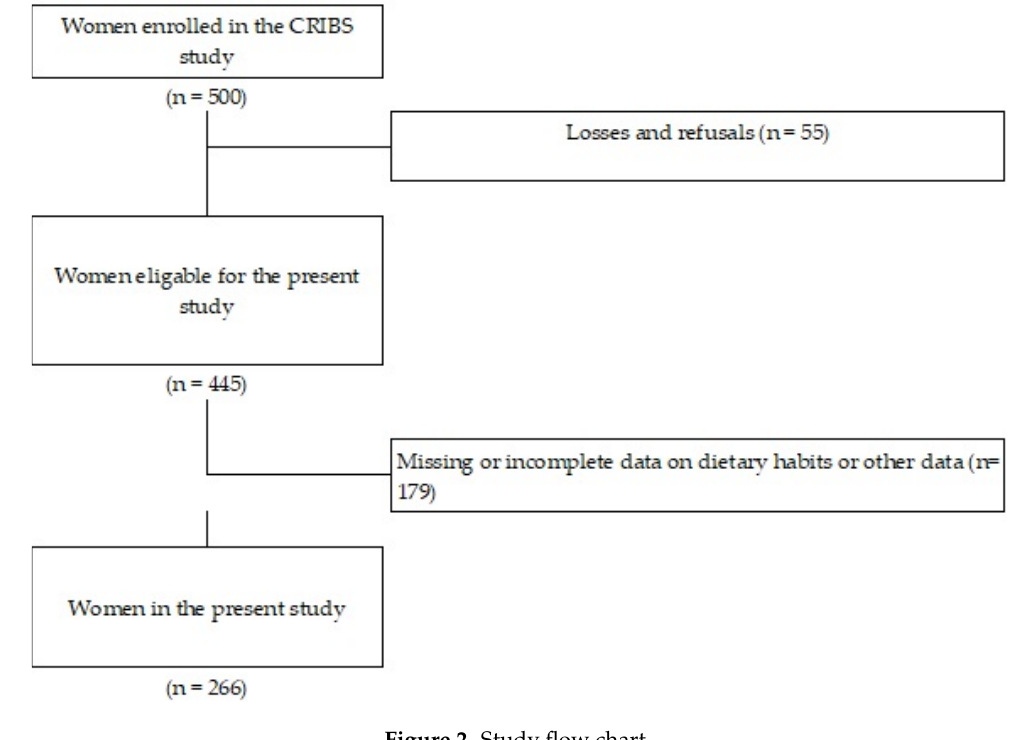
Table 1. Food categories used for the calculation of the Mediterranean Diet Serving Score (MDSS).